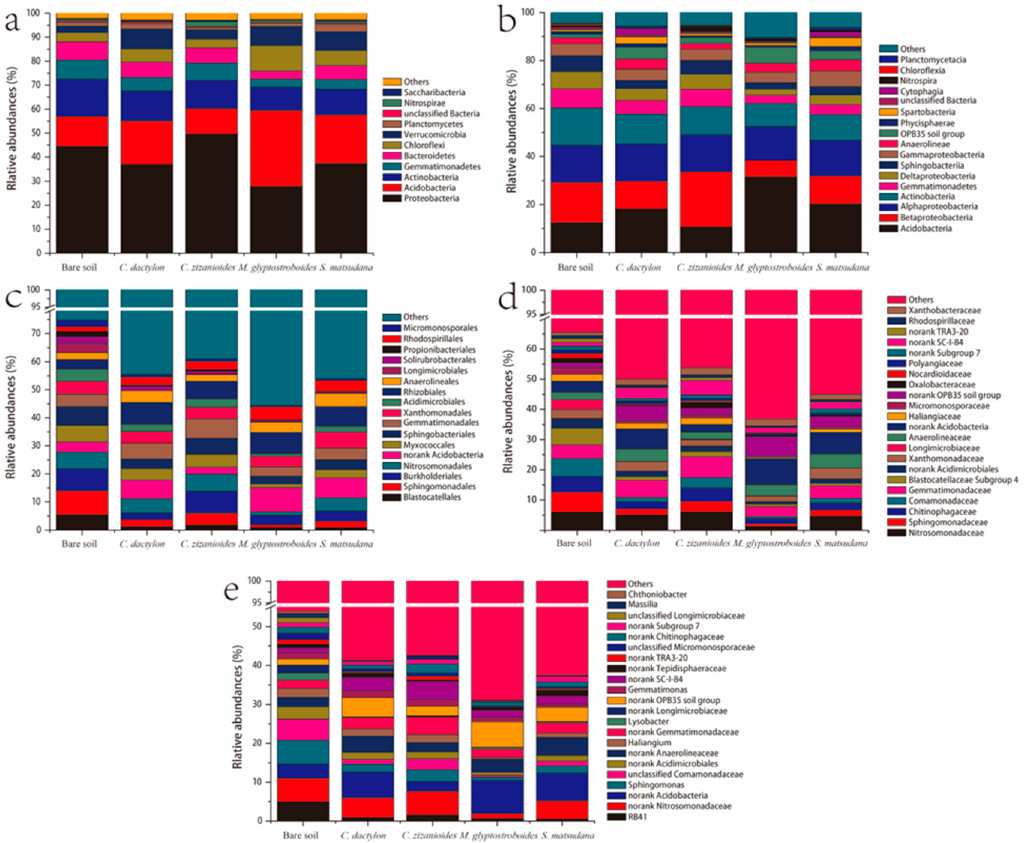
Figure 2. Relative abundance of bacterial sequences at the phylum ( a ), class ( b ), order ( c ), family ( d ) and genus ( e ) levels.